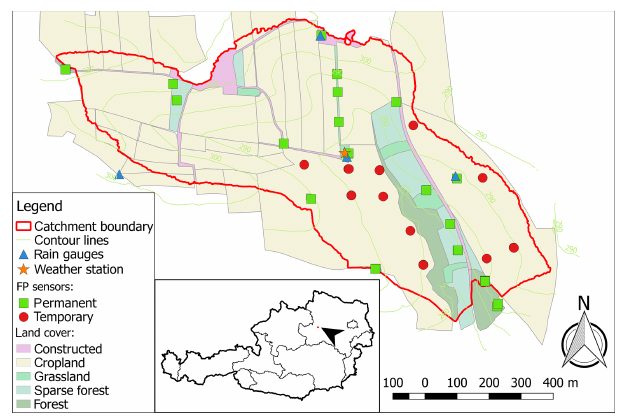
Figure 2. Locations of the permanent and temporary FP sensors in the HOAL catchment, marked by green squares and red circles,